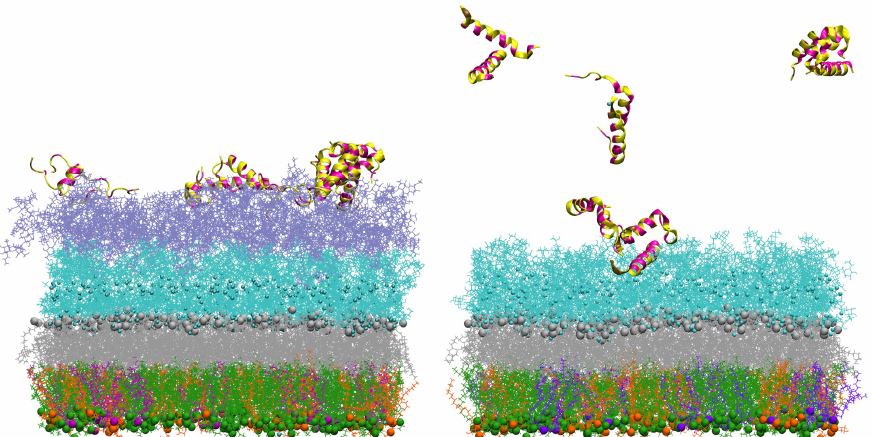
Figure 9. Representations of the Gram-negative bacteria’s outer membrane interacting with twelve peptides initially placed in solution 2 nm above the membrane’s last layer. On the ( left ), snapshot of the outer membrane with 2 O-antigen units at 400 ns simulation time, and on the ( right ), snapshot of the outer membrane at ~100 ns simulation time. PVPE lipids are green, PVPG lipids are orange, PVCL2 is violet, and Lipid A is gray, all represented by sticks and beads. The core region is represented by cyan lines, neutralizing Ca 2+ ions in core region as small cyan beads and the 2 O-antigen units are represented by purple lines. Peptides are shown as ribbons, with polar and charged residues in yellow and hydrophobic residues in magenta. Water molecules are not shown for